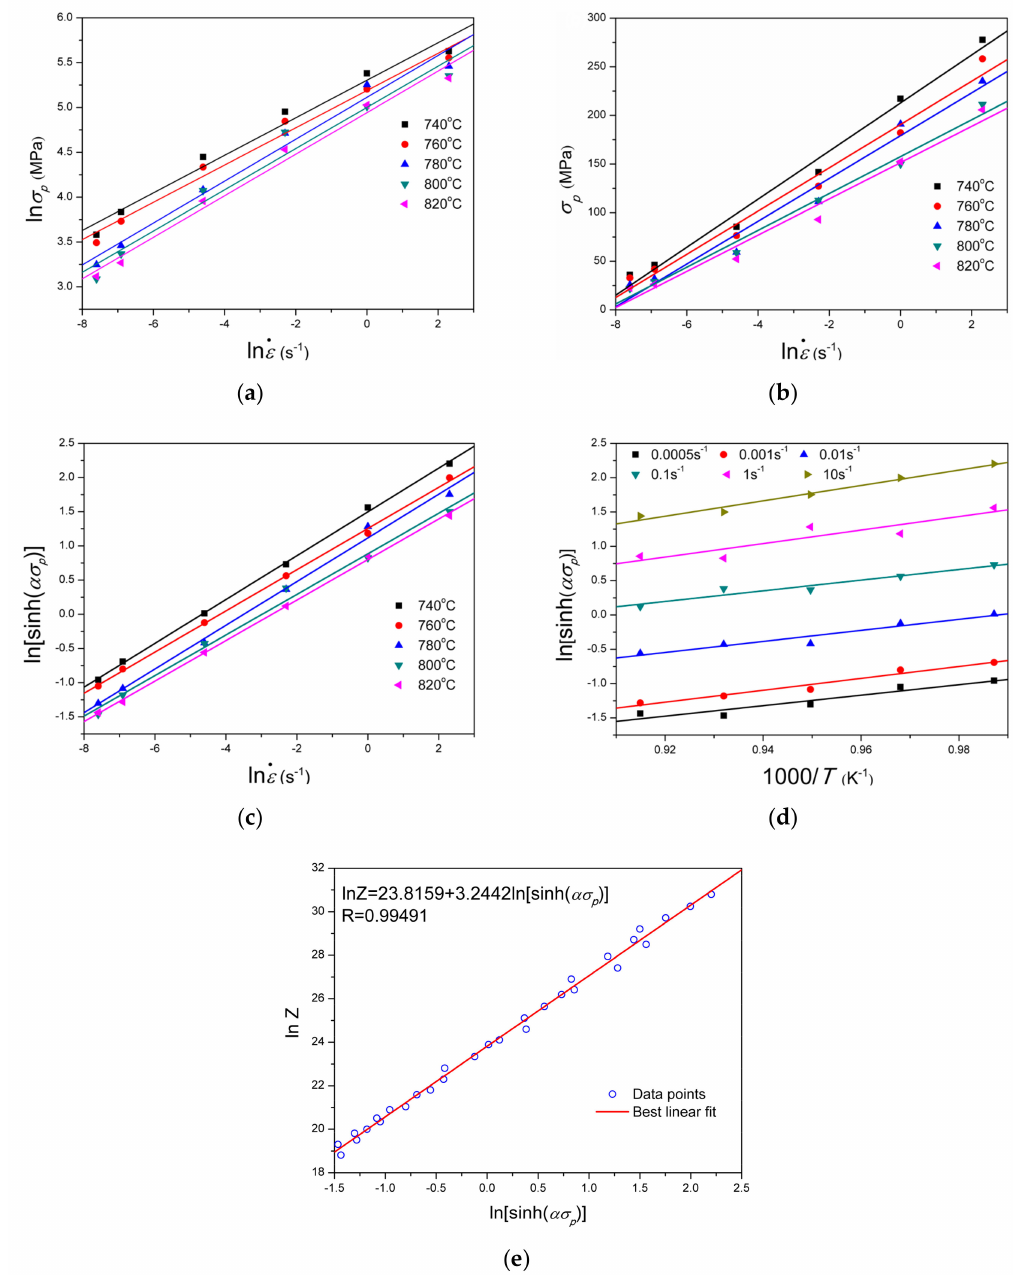
. ε ; ( b ) β by plotting σ p vs. ln